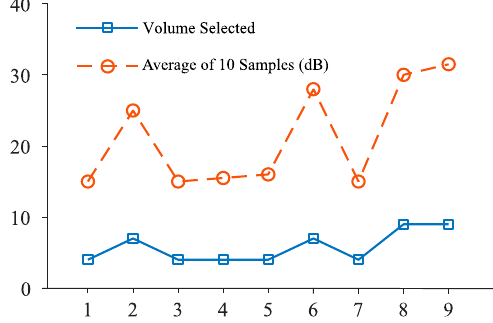
Figure 7. Volume level for selected sets.